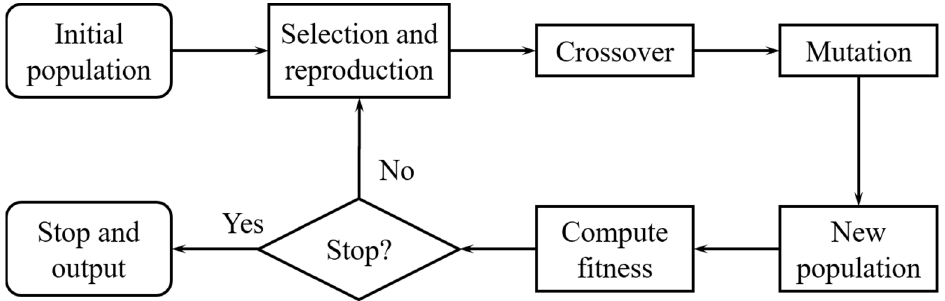
Figure 10. The stream map of the single objective genetic algorithm.